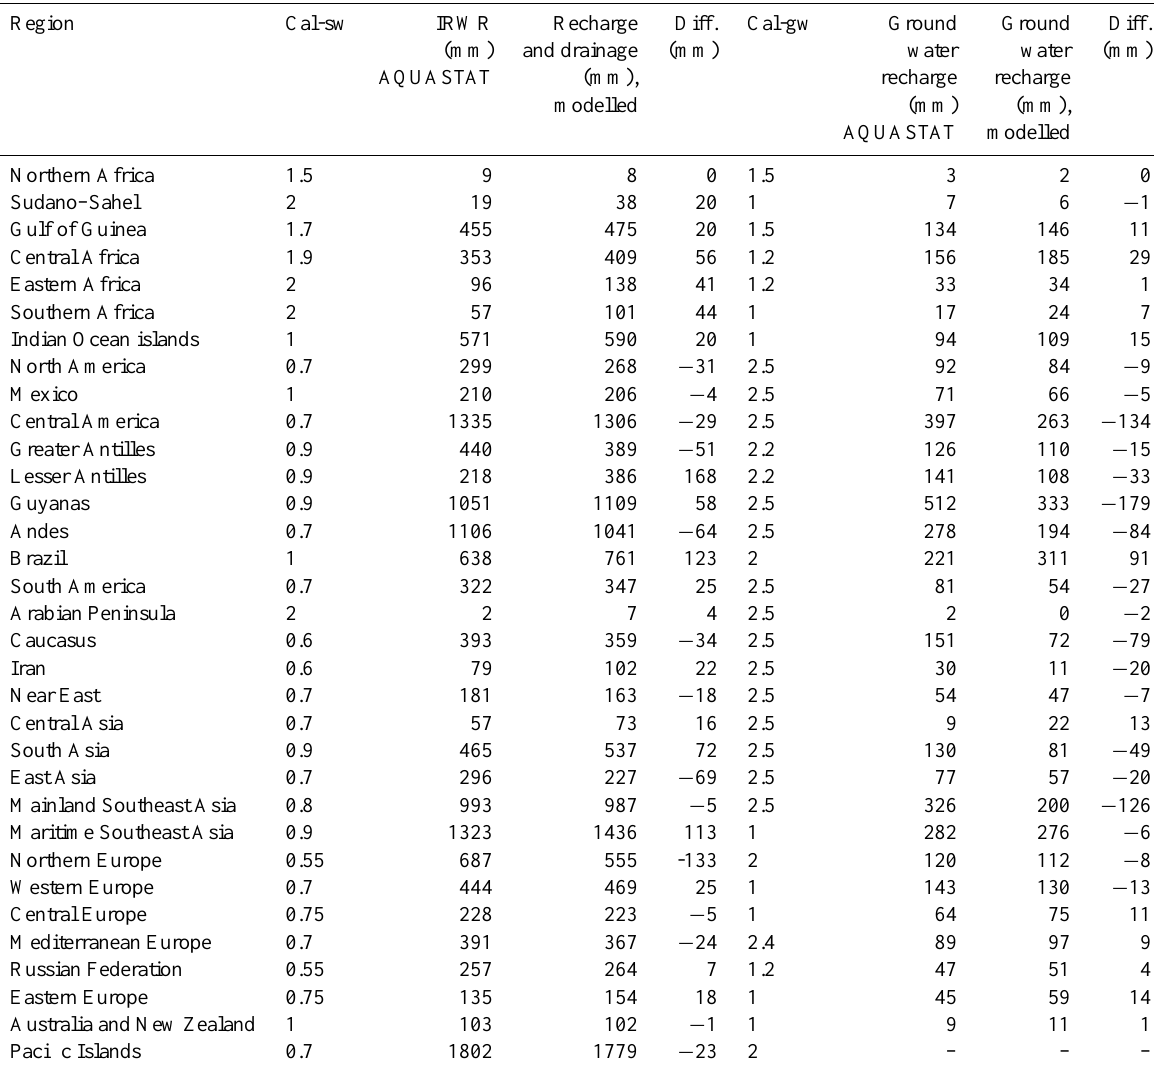
Table 4. Calibration factors per hydrological region. Region Cal-sw IRWR Recharge Diff. Cal-gw Ground Ground Diff.